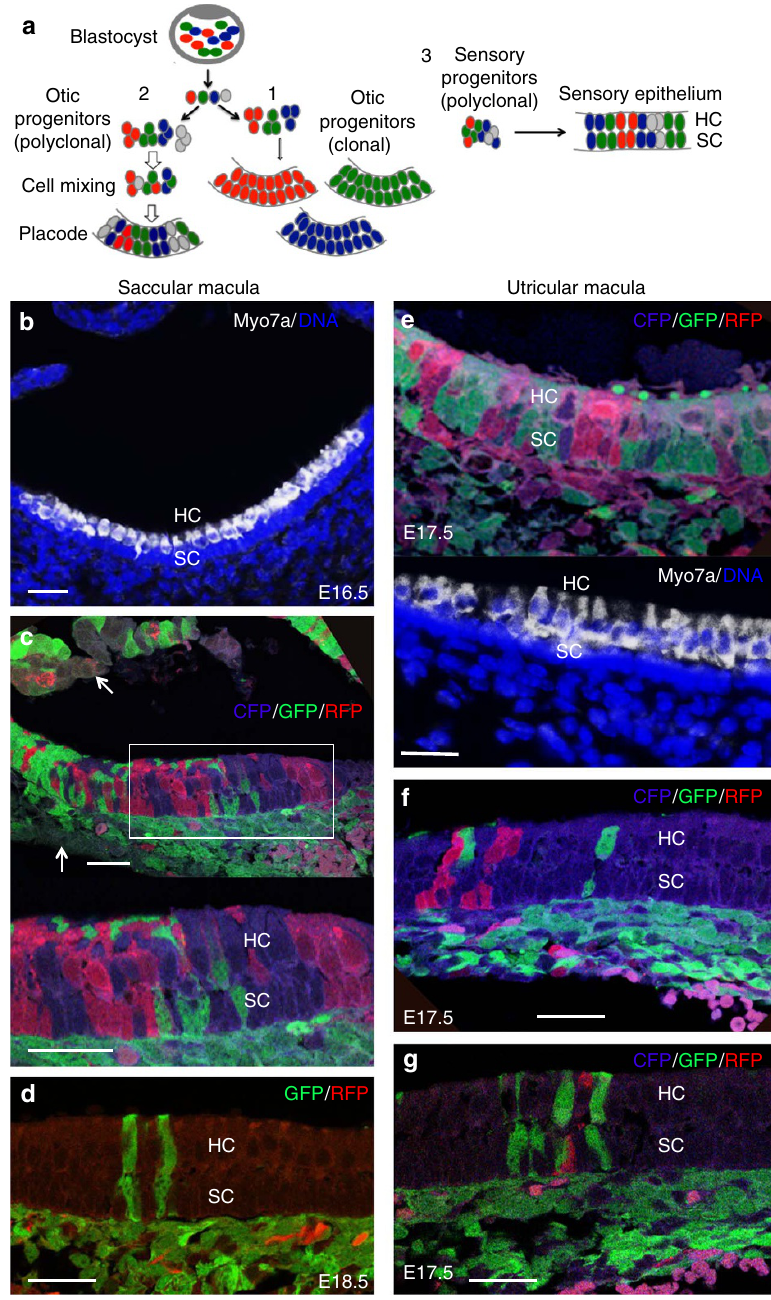
Figure 1 | Sensory hair and supporting cells are related in the saccular and utricular macula. ( a ) Schematic of expected results of inner ear sensory organs obtained in this study. (1) In the case where the inner ear is generated from a single bipotential progenitor, the otic ectodermal cells show a single colour (on the right). (2) In the case where putative pluripotent/bipotent progenitors proliferate in the otic ectoderm and mix during placodal thickening, the otic placode would always show the same combination of colours (on the left). (3) As the neural crest cells are known to migrate into the otic placode to contribute to inner ear development, in the case each otic placode is derived from several ectodermal and neural crest progenitors that are separately generated, the otic placode would be similar to the placode indicated in (2). These scenarios also apply to the sensory organs in the inner ear to determine whether they are derived from multiple putative bipotent progenitors that proliferate in the sensory primordium and mix during differentiation to give rise to sensory hair cells and underlying supporting cells. For the snail-shaped cochlea, see Fig. 2a. ( b ) Merged image showing hair cells (HCs) in macula labelled with anti-Myo7a (white) and nuclear staining with Hoechst. ( c ) Composite image from a section adjacent to ( b ) with relatively balanced chimerism showing single-colour clusters consisting of supporting cells (SCs) and HCs in the saccular macular epithelium. Arrows point to uncoloured cells. ( d ) Composite image showing E18.5 saccular macular epithelium (injected with decreased number of RFP- and GFP-mESCs) with two green two-cell clusters consisting of one HC and one SC. ( e ) Upper panel: composite image showing E17.5 chimeric utricular macular epithelium showing single-colour clusters (red, green and blue) consisting of SCs and their associated HCs. Lower panel: an adjacent section of the upper panel stained with anti-Myo7a for HCs and Hoechst. ( f , g ) Composite images showing utricular macula (injected with decreased number of RFP-, CFP- and GFP-mESCs) with two-cell clusters consisting of one HC and one associated SC. Also see Supplementary Figs 1 and 2. Scale bar: 20 m